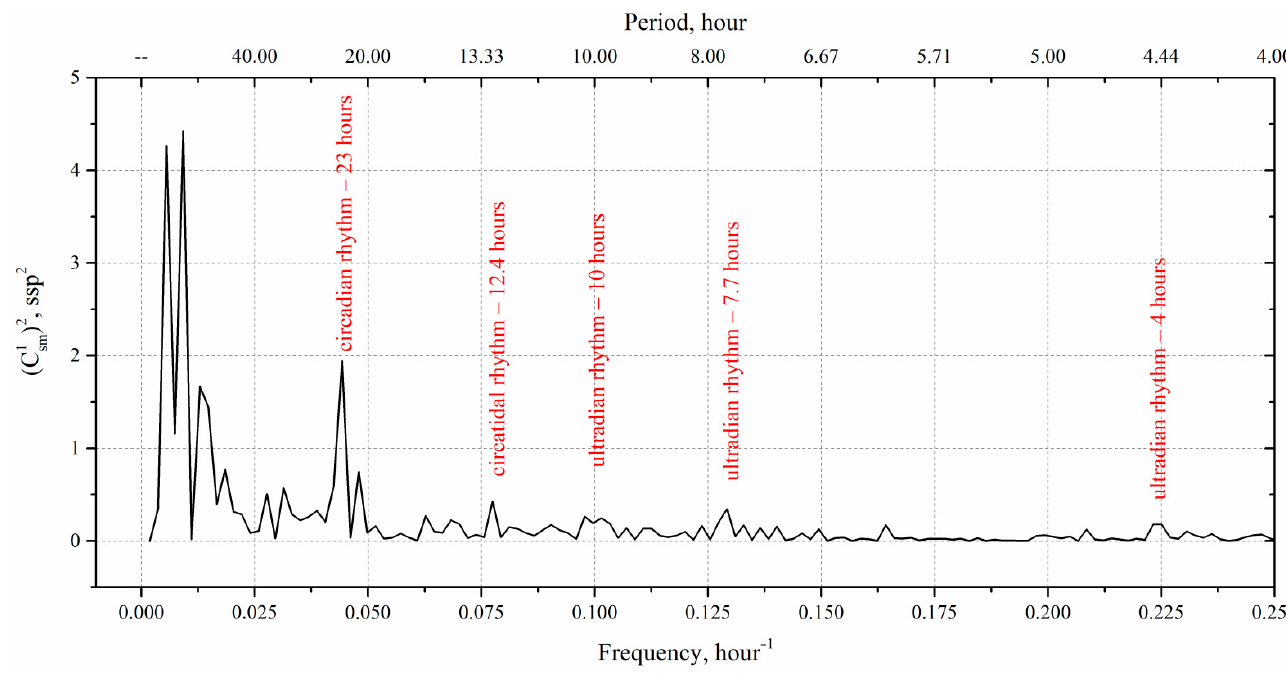
Figure 8. Plankton content in 1 L near the mooring station. Red line—result after processing the samples obtained by a net. Black line—time series of holographic measurements of plankton number over the same period of time.